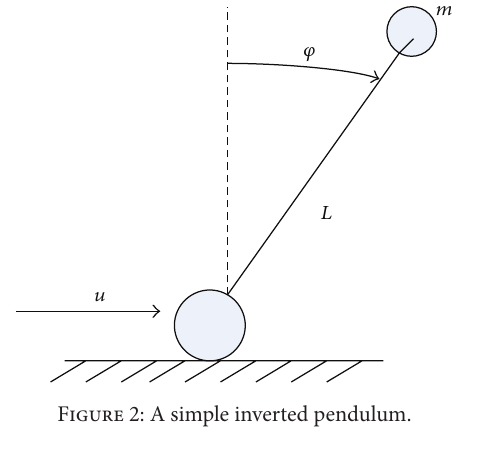
Figure 4: Values of the C-A delay 𝜏(𝑘) .